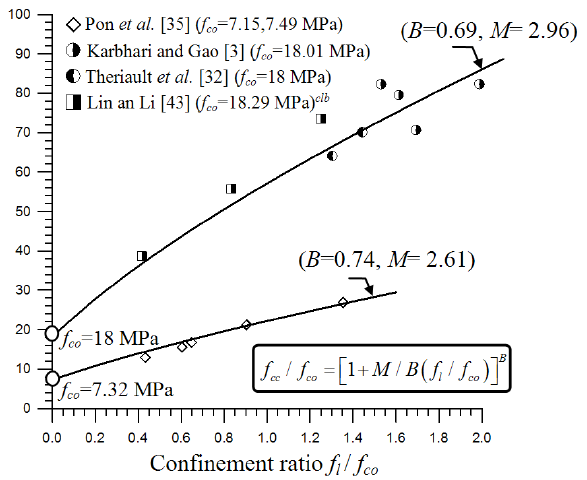
Figure 5. Verification of Johnston criterion for low-strength ( f confined concrete.